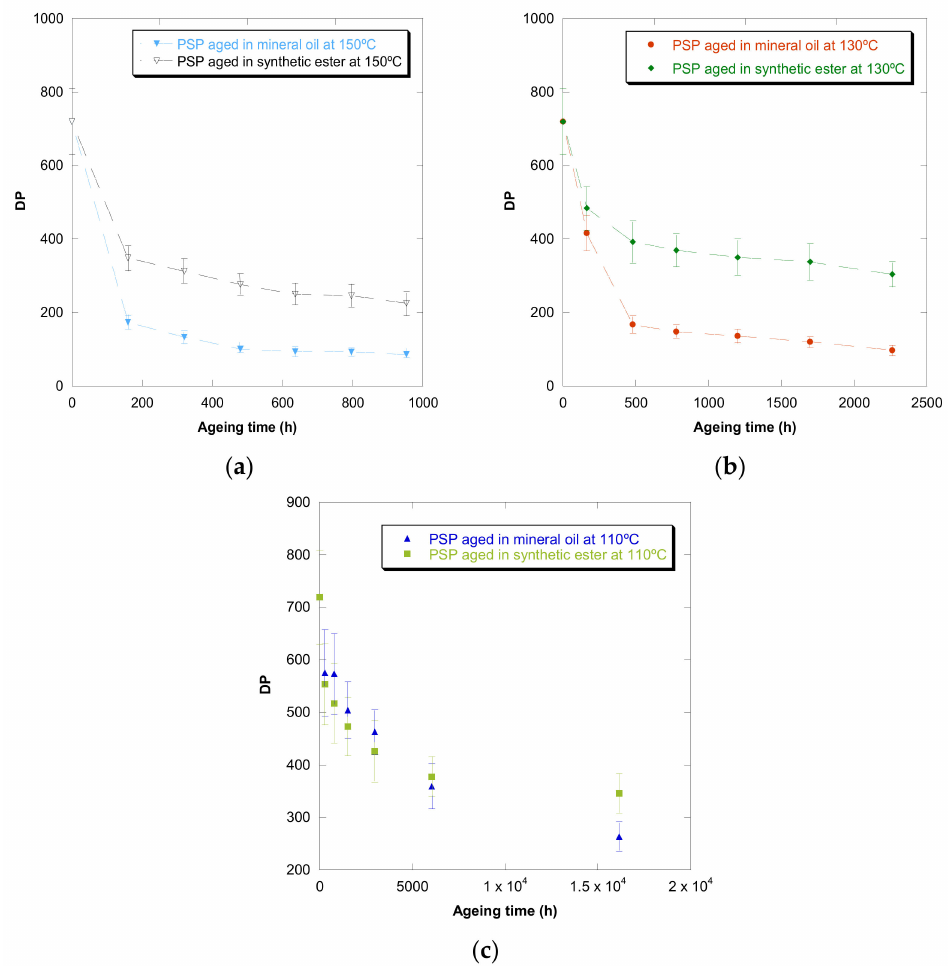
Figure 1. Evolution of the DP as a function of temperature for cellulose-board PSP 3055 aged in mineral oil and in synthetic ester at 150 ◦ C ( a ), 130 ◦ C ( b ), and 110 ◦ C ( c